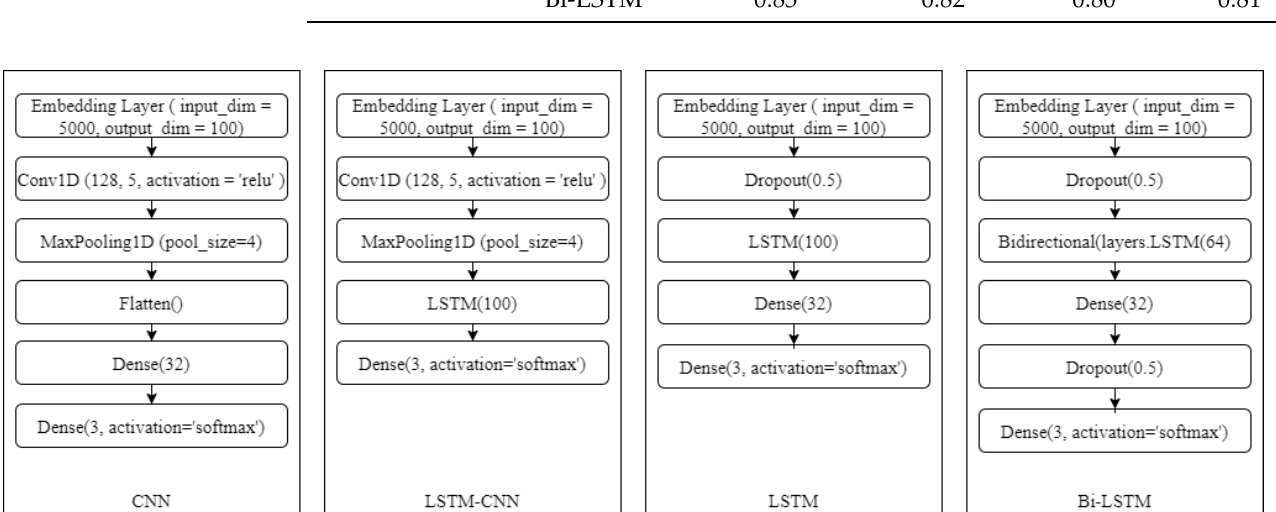
Figure 6. Architecture of deep learning models used for sentiment